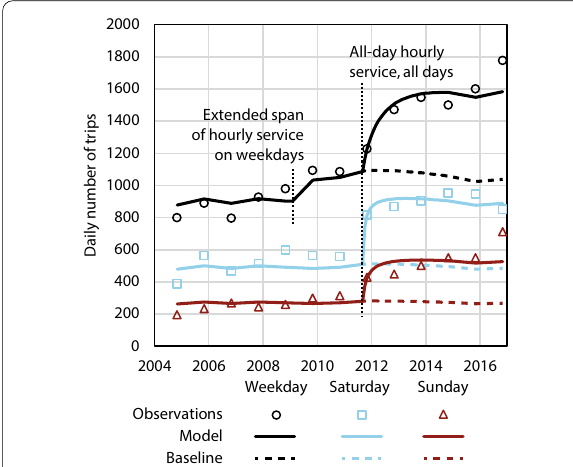
Fig. 4 Patronage development in case B, Österlenbanan (excluding trips with origins or destinations in other parts of the network), showing annual autumn measurements and model estimations of the patronage development with and without off‑peak service improvements (the latter corresponds to the counterfactual baseline scenario)